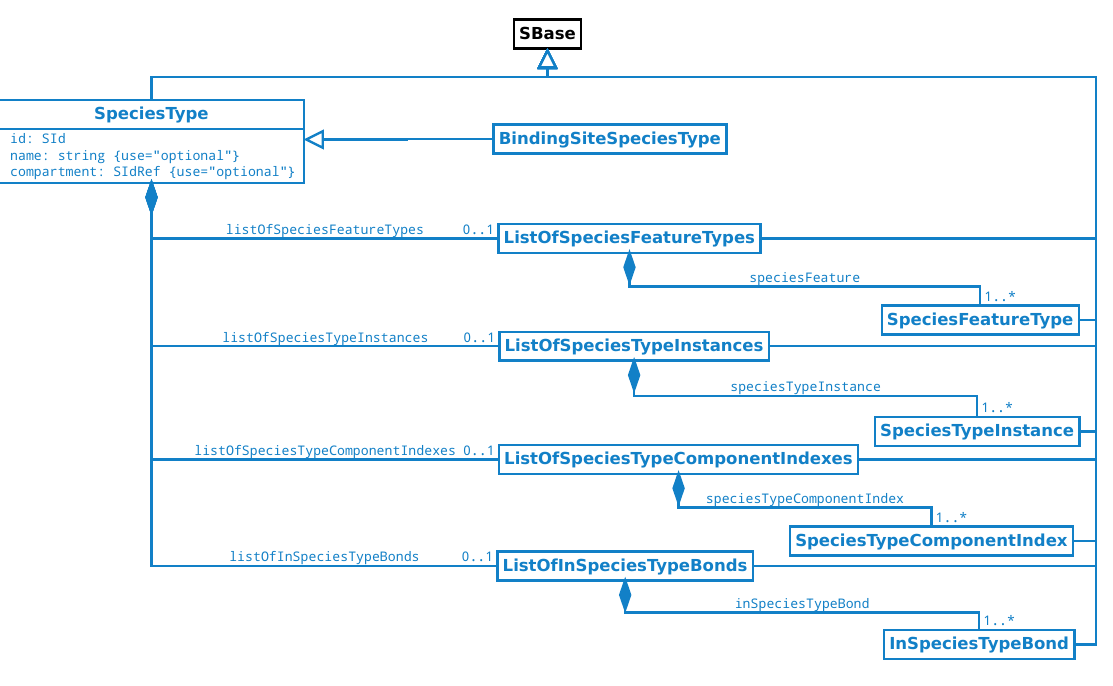
Figure 3: The definition of the SpeciesType